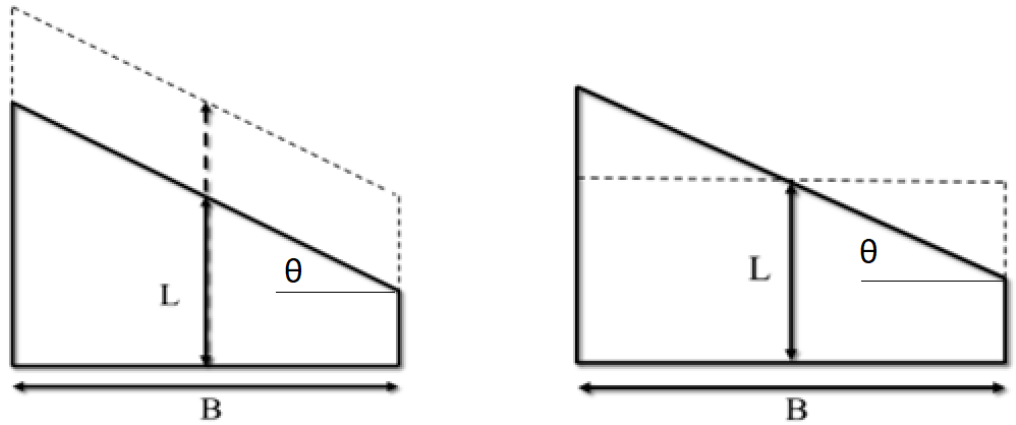
Figure 2. Single slope solar still geometry variation.